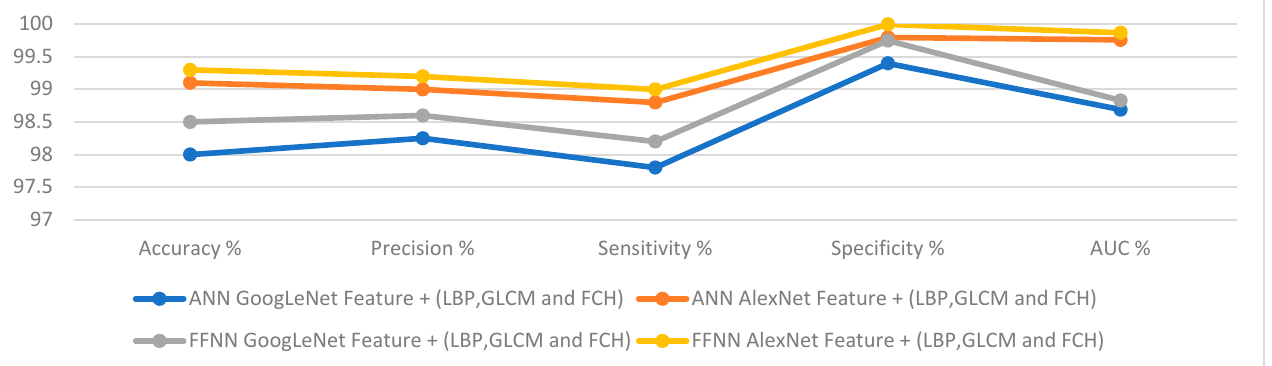
Figure 22. Display of the performance of the ANN and FFNN based on hybrid features for diagnosing a low GI dataset.